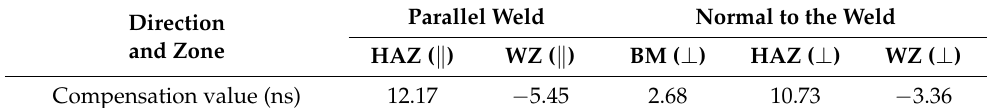
Table 1. Compensation acoustic time for each zone of measured material.